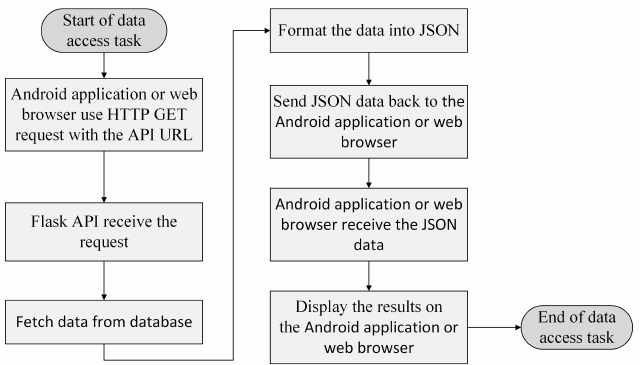
Figure 7. Flowchart showing the data access via Android application and web browser using the Flask API.